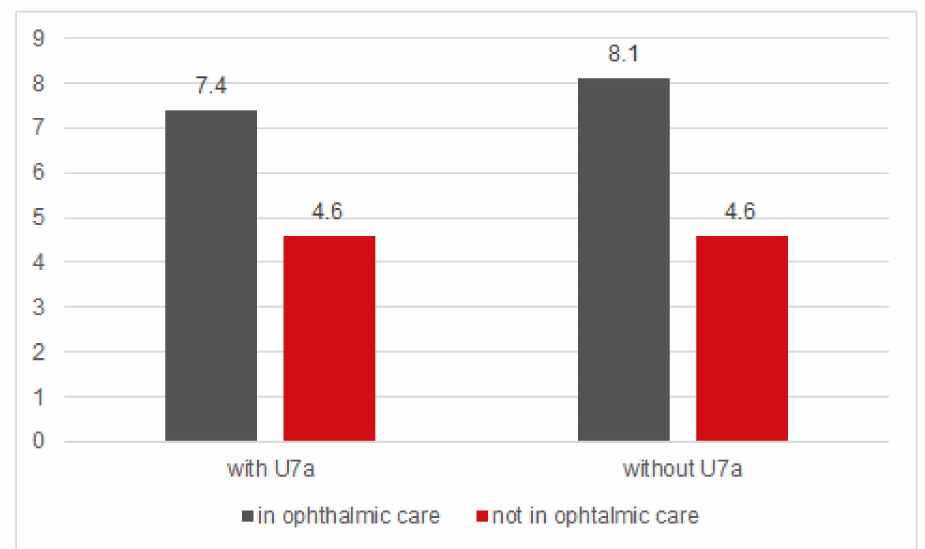
Figure 2. Prevalence (%) of children with PHE visual acuity < 0.7 (mon- or binocular) stratified by U7a participation. PHE preschool health examination; VA visual acuity; U7a newly introduced paediatric health examination at end of third year of